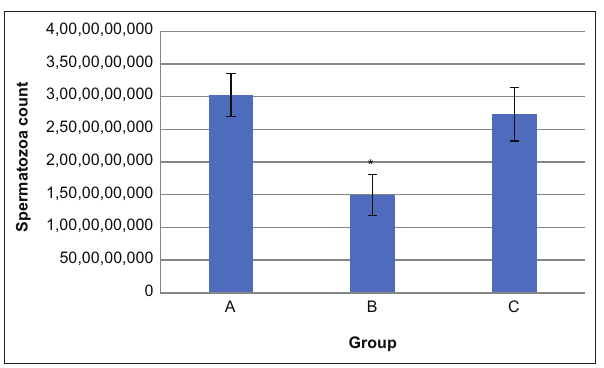
Figure-1: Concentration of spermatozoa from cauda epididymal semen of rats in Group A, Group B, and Group C. Statistical analysis showed significant difference (*) with p<0.05.